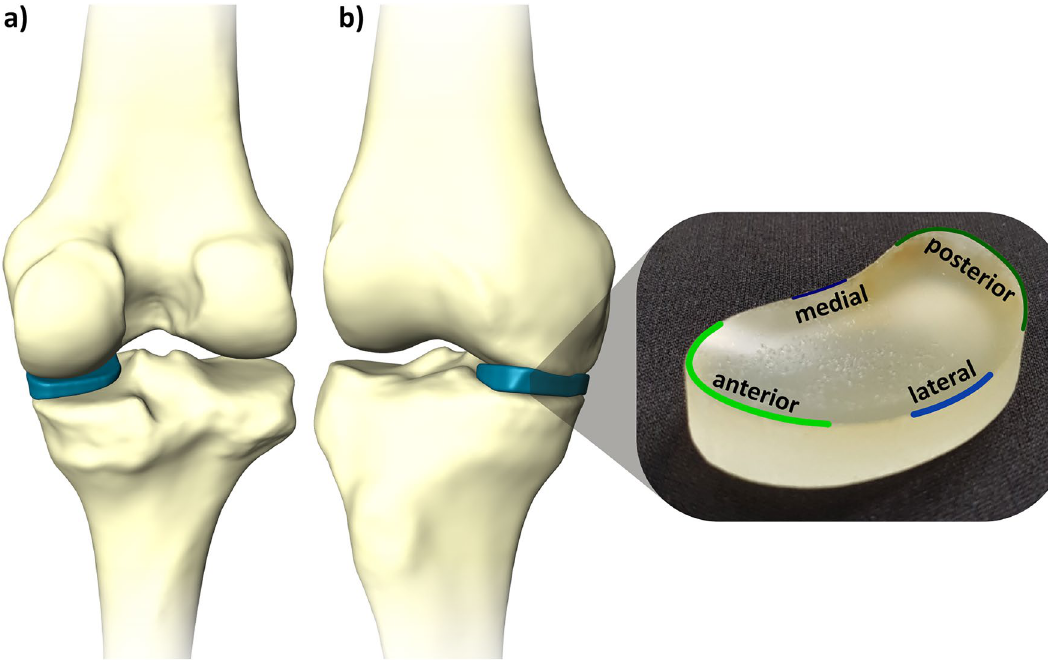
Figure 3. Knee spacer implant. An example of a knee spacer template filling the medial joint gap depicted in posterior and anterior